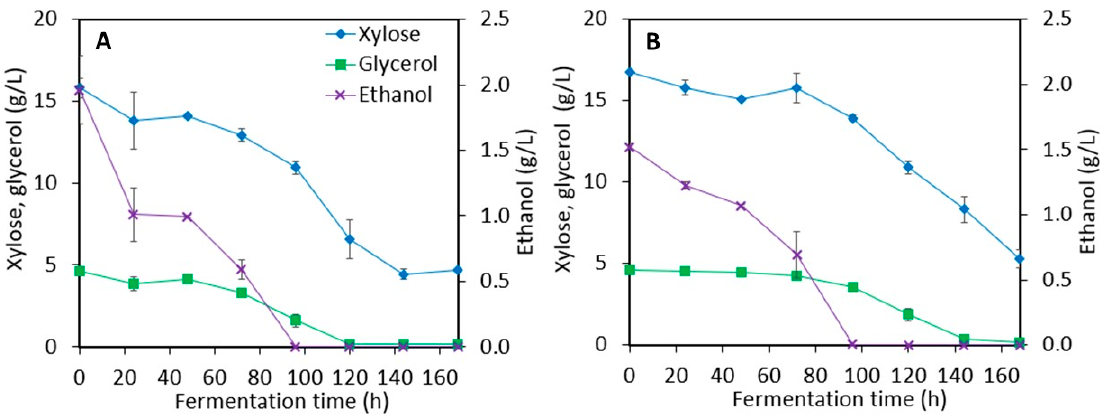
Figure 8. Xylose ( (cid:7) ), glycerol ( (cid:4) ), and ethanol ( x ) consumption by P . rhodozyma in ( A ) 36% concentrated Figure 8. Xylose ( ♦ ), glycerol ( ■ ), and ethanol ( x ) consumption by P . rhodozyma in ( A ) 36% stillage media with 6.0 g / L yeast extract and ( B ) 36% concentrated stillage media with 1.0 g / L concentrated stillage media with 6.0 g/L yeast extract and ( B ) 36% concentrated stillage media with ammonium 1.0 g/L ammonium sulfate.